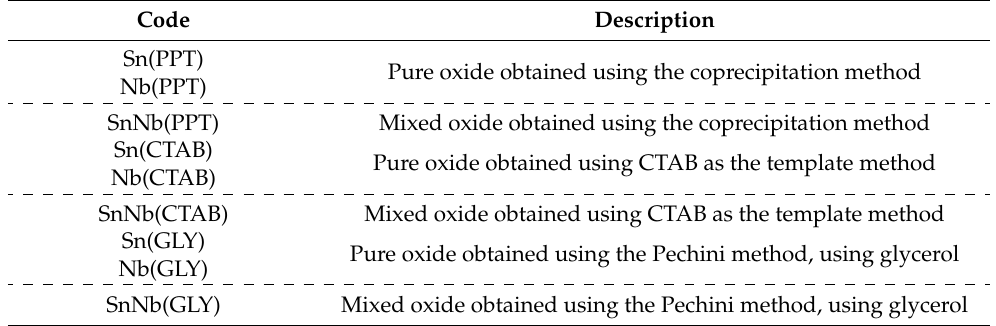
Table 1. Code of the catalysts and the respective descriptions. Code Description Sn(PPT) Pure oxide obtained using the coprecipitation method Nb(PPT) SnNb(PPT) Mixed oxide obtained using the coprecipitation method Sn(CTAB) Pure oxide obtained using CTAB as the template method Nb(CTAB) SnNb(CTAB) Mixed oxide obtained using CTAB as the template method Sn(GLY) Pure oxide obtained using the Pechini method, using glycerol Nb(GLY) SnNb(GLY) Mixed oxide obtained using the Pechini method, using